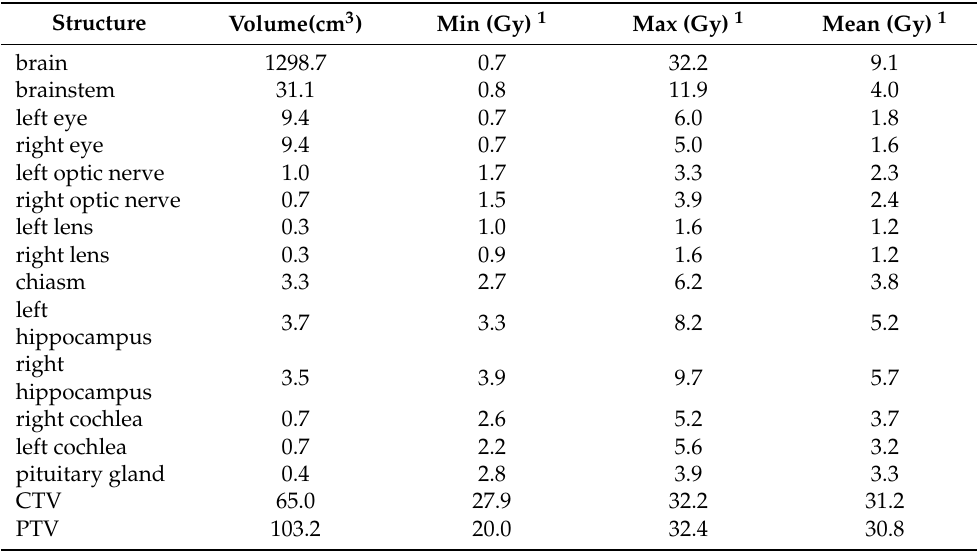
Table 5. Average dose to OARs for 18 brain oligometastatic patients treated with